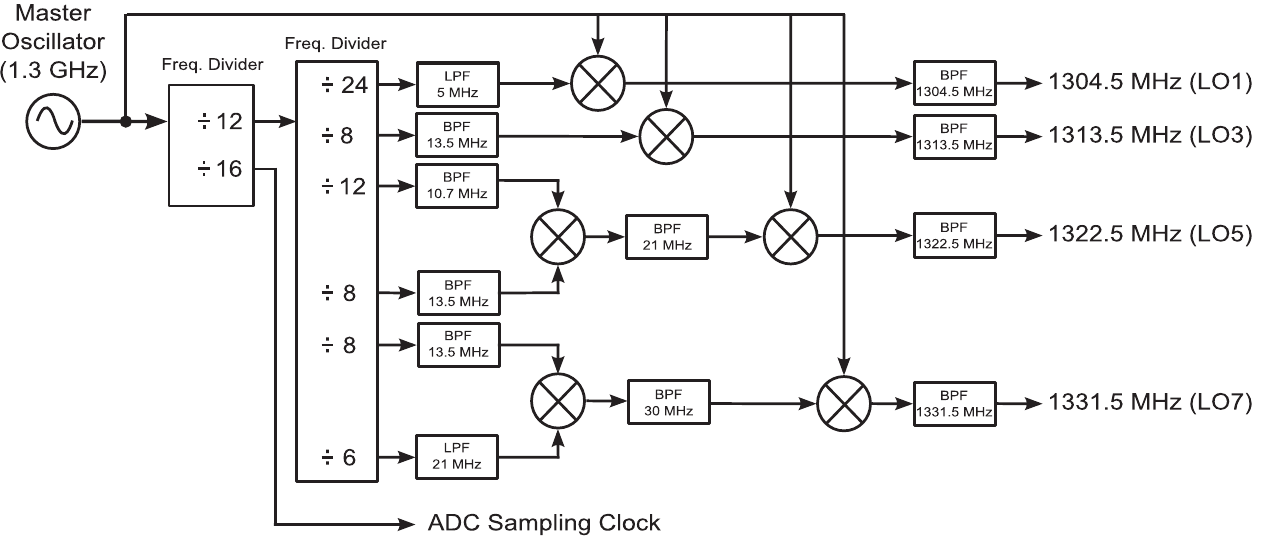
FIG. 6. LO and ADC sampling clock generation for digital LLRF control system with four different IFs. AD9510 from analog device is used for the frequency